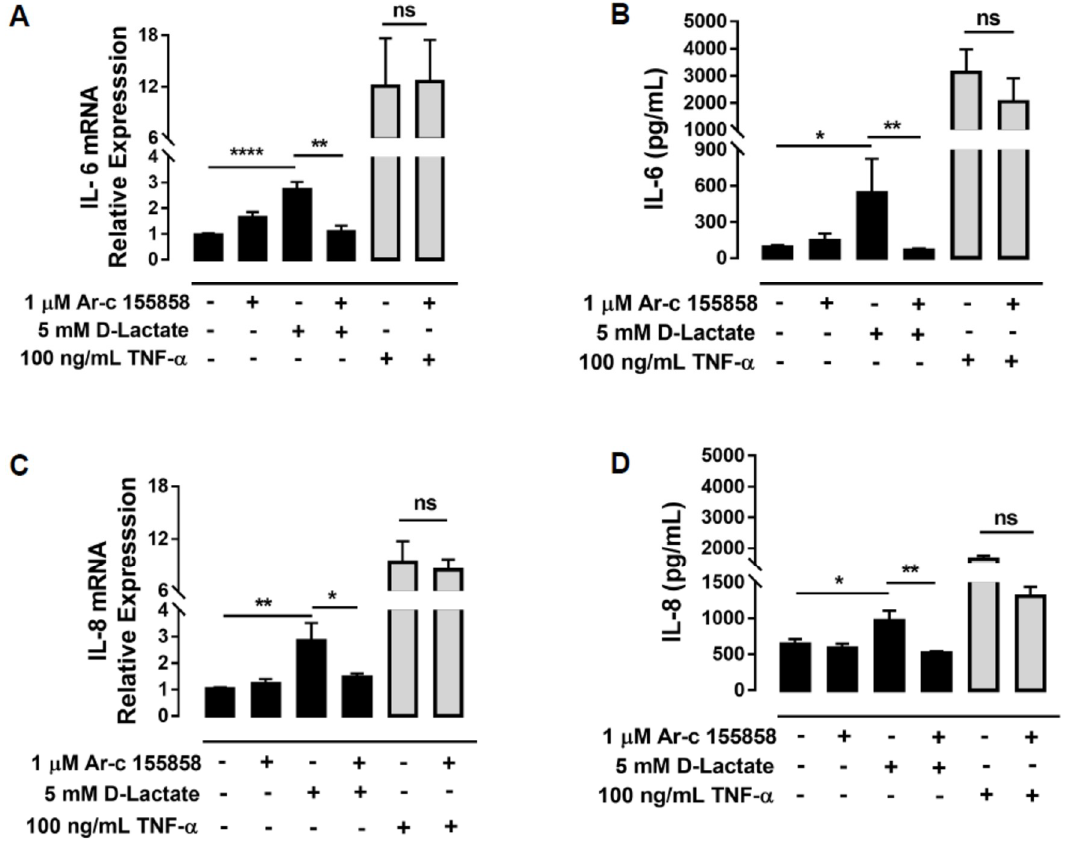
Figure 3. The influx of D-lactate by MCT1 increases the expression of IL-6 and IL-8. ( A , C ) The relative mRNA levels of IL-6 and IL-8 in bFLSs pretreated with Ar-c 155858 and then stimulated with D-lactate or bTNF- α were normalized by S9 ribonucleoprotein (housekeeping gene). ( B , D ) The IL-6 and IL-8 concentrations in the supernatants of bFLSs treated with Ar-c 155858 and stimulated with D-lactate or bTNF- α were measured by ELISA. The mean ± SEM of five independent experiments is shown. NS: not significant. * p < 0.05, ** p < 0.01, **** p < 0.0001 compared with control or D-lactate-treated cells.